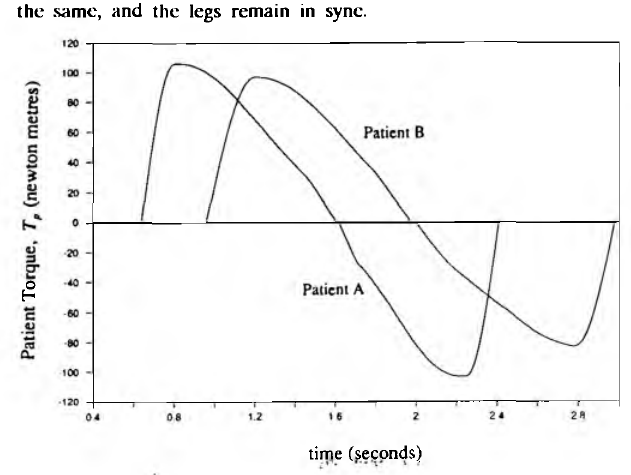
Fig 7: Torque characteristics for both patients in extension and